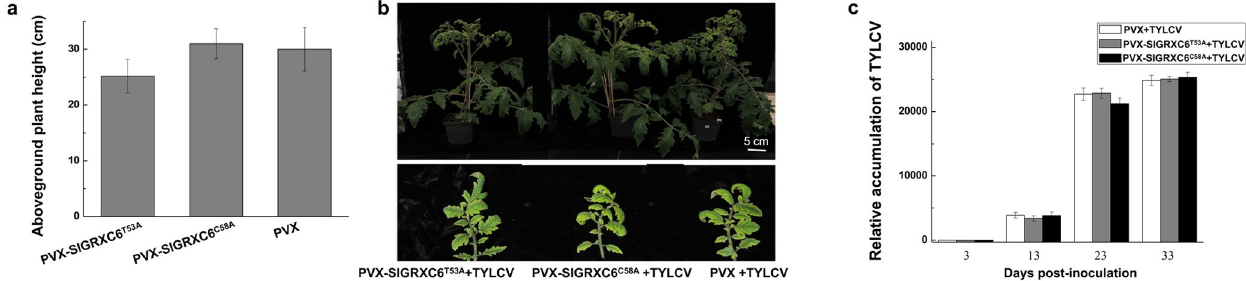
Fig 4. The V2-SlGRXC6 interaction is critical to TYLCV infection. (a) The aboveground height of PVX-, PVX-SlGRXC6 T53A -, or PVX-SlGRXC6 C58A - inoculated tomato plants as measured at 16 dpai. (b) Symptoms in control, PVX-SlGRXC6 T53A -, PVX-SlGRXC6 C58A -inoculated plants. Leaves were photographed 23 days after TYLCV inoculation. Bar: 5 cm. (c) The accumulated TYLCV viral DNA in systemic leaves as measured by qPCR. Accumulated levels of viral genomic DNA were tested in PVX-, PVX-SlGRXC6 T53A -, PVX-SlGRXC6 C58A -treated tomato plants infected with TYLCV at 3, 13, 23, and 33 dpi as in Fig 2A. Data are means ± SD (n = 3). Experiments were repeated three times with similar results.